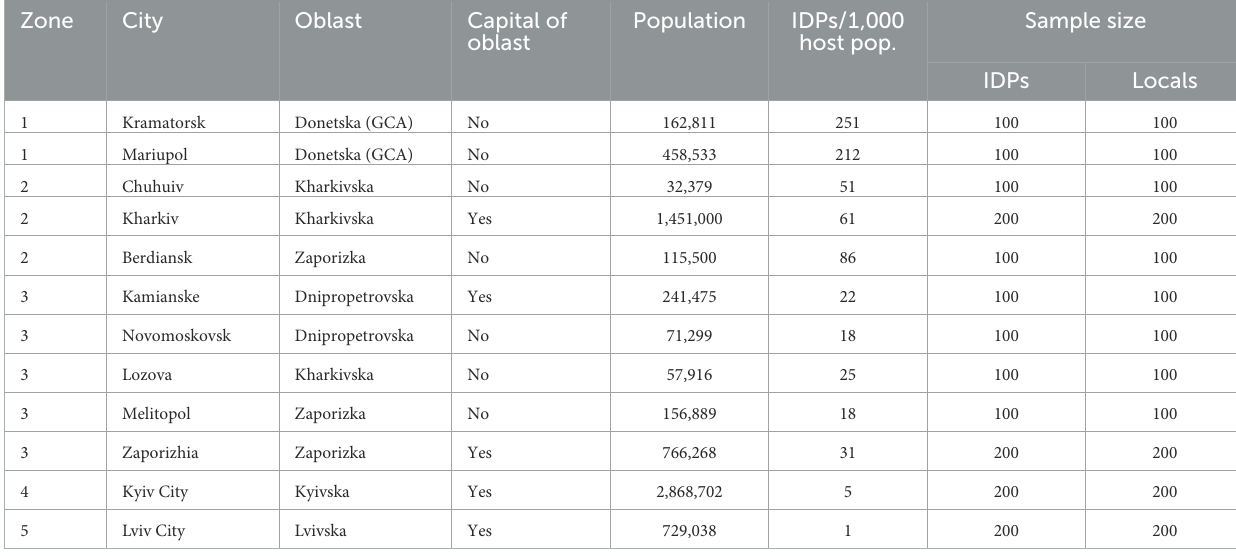
TABLE 1 Sample site